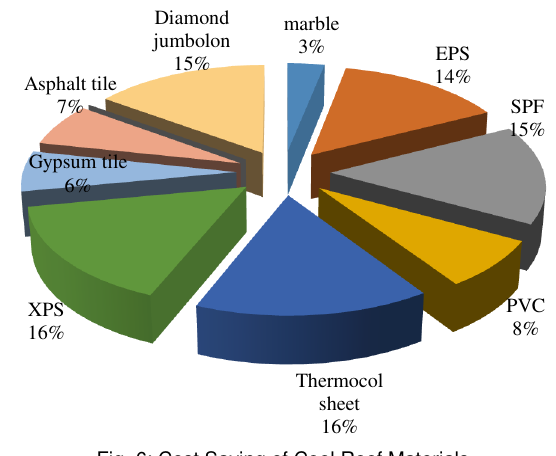
Fig. 6: Cost Saving of Cool Roof